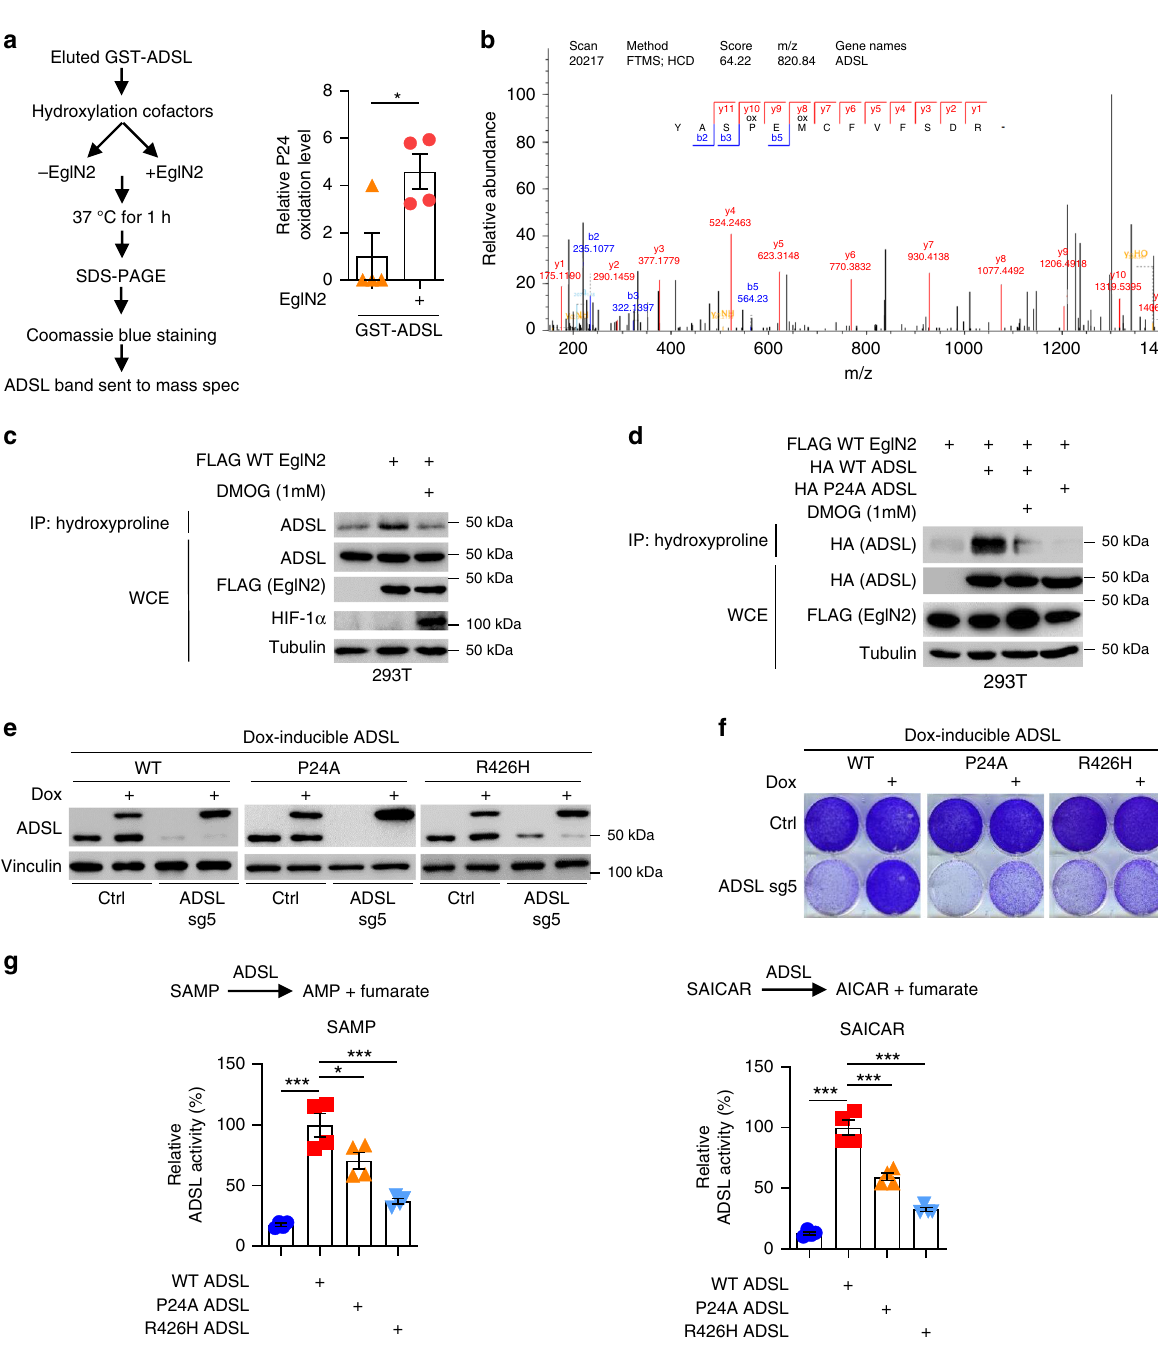
Fig. 4 ADSL is hydroxylated by EglN2 on Proline 24. a In vitro hydroxylation of GST-ADSL in the presence or absence of recombinant EglN2. Bar graph represents the normalized ratio of the intensity of the oxidized P24-containing peptide to that of ADSL full protein. Error bars represent SEM, n = 4, * P < 0.05 was calculated using two-tailed Student ’ s t -test. b Fragmentation spectrum of proline hydroxylated peptide YASPEMCFVFSDR detected following experimental procedure described in ( a ). c , d IB of WCE and IP of lysates from 293T cells transfected with the indicated plasmids, and treated as indicated overnight. e IB of lysates from MDA-MB-231 cells overexpressing the indicated dox-inducible ADSL, transduced and treated as indicated. f Representative image of 2-D proliferation of MDA-MB-231 cells overexpressing the indicated dox-inducible ADSL, transduced and treated as indicated. g Enzymatic activity of WT, P24A or R426H ADSL in the presence of its substrate adenylosuccinate (SAMP) or succinylaminoimidazole carboxamide ribotide (SAICAR). Bar graphs represent the normalized percentage of ADSL activity compared with WT ADSL. Error bars represent SEM, n = 4, * P < 0.05, ** P < 0.01, *** P < 0.001 were calculated using one-way ANOVA followed by Tukey ’ s multiple comparison test. Source data are provided as a Source Data fi